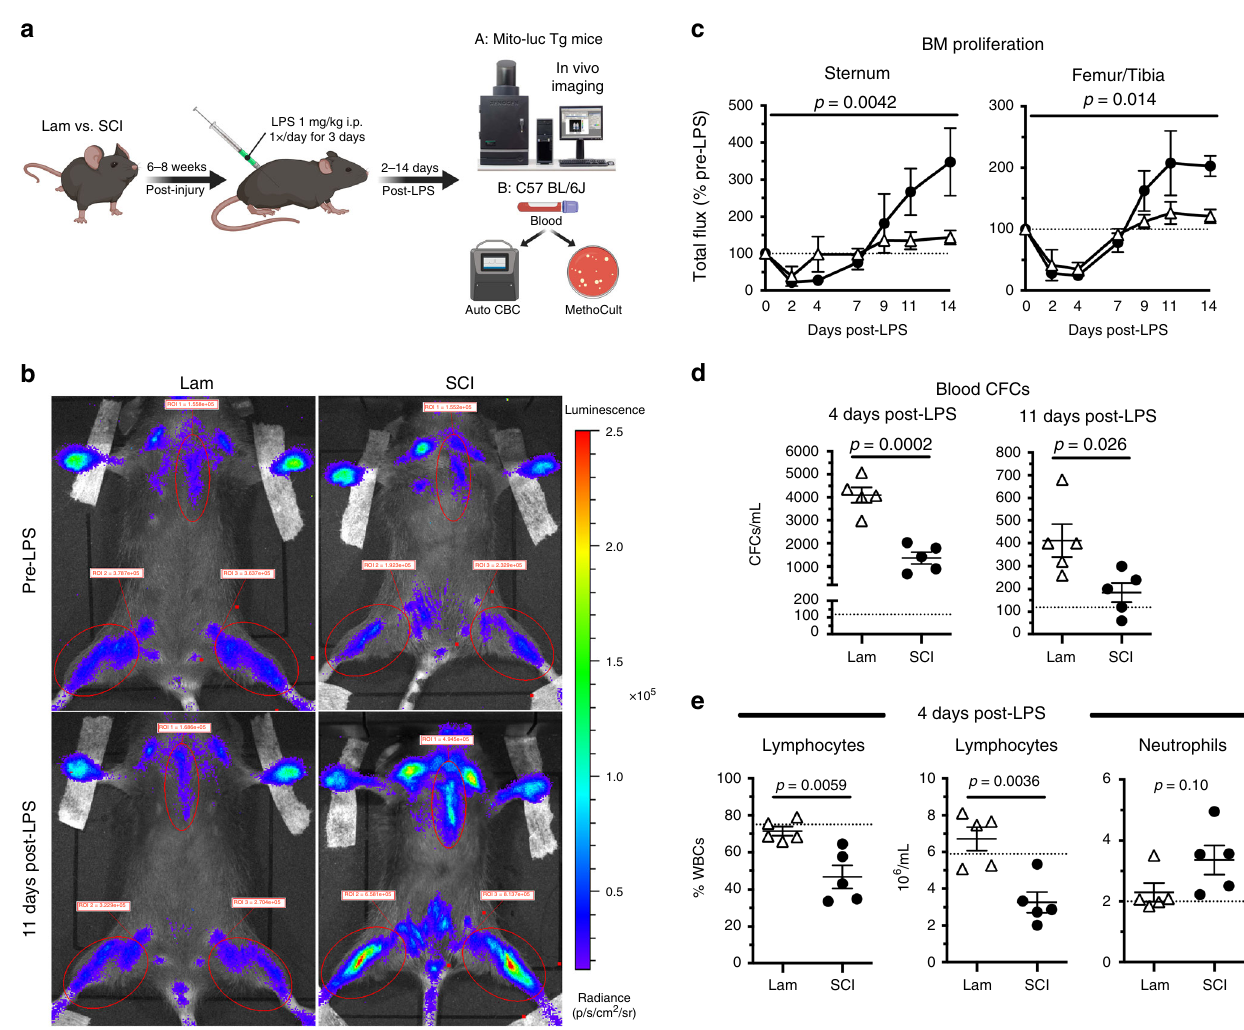
Fig. 7 Stimulating hematopoiesis with LPS in chronic-injured mice recapitulates acute bone marrow responses to injury. a Experimental outline demonstrating T3 transection SCI and sham injury followed by 6 – 8 weeks of recovery prior to LPS stimulation (1 mg kg − 1 day − 1 i.p. for 3 days). Mice then underwent in vivo imaging of bone marrow proliferation (A: Mito-luc transgenic mice) or automated CBC and MethoCult assay of whole blood (B: C57BL/ 6J mice). b Bioluminescent images from representative Lam and SCI mice before and 11 days post-LPS. c Quanti fi cation of total fl ux in sternum and femur/ tibia regions as a % of pre-LPS levels (dotted line). d Total number of CFCs per mL whole blood at 4 and 11 days post-LPS. e Lymphocytes (% of WBCs and total numbers) and neutrophils (total numbers) in blood 4 days post-LPS. All data are mean ± SEM, two-way ANOVA with repeated measures ( c ) and